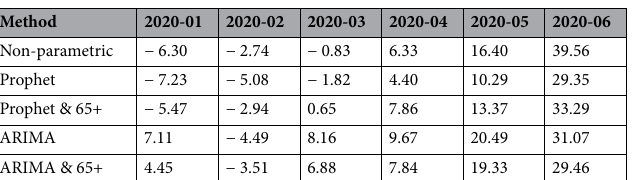
Table 1. The values of P and P for the first six months of 2020 based on five previous years of historic data for different modeling approaches.